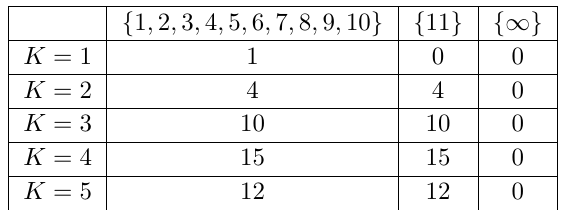
Table 8 . Number of Bethe roots for decomposed BAE with M = 11.